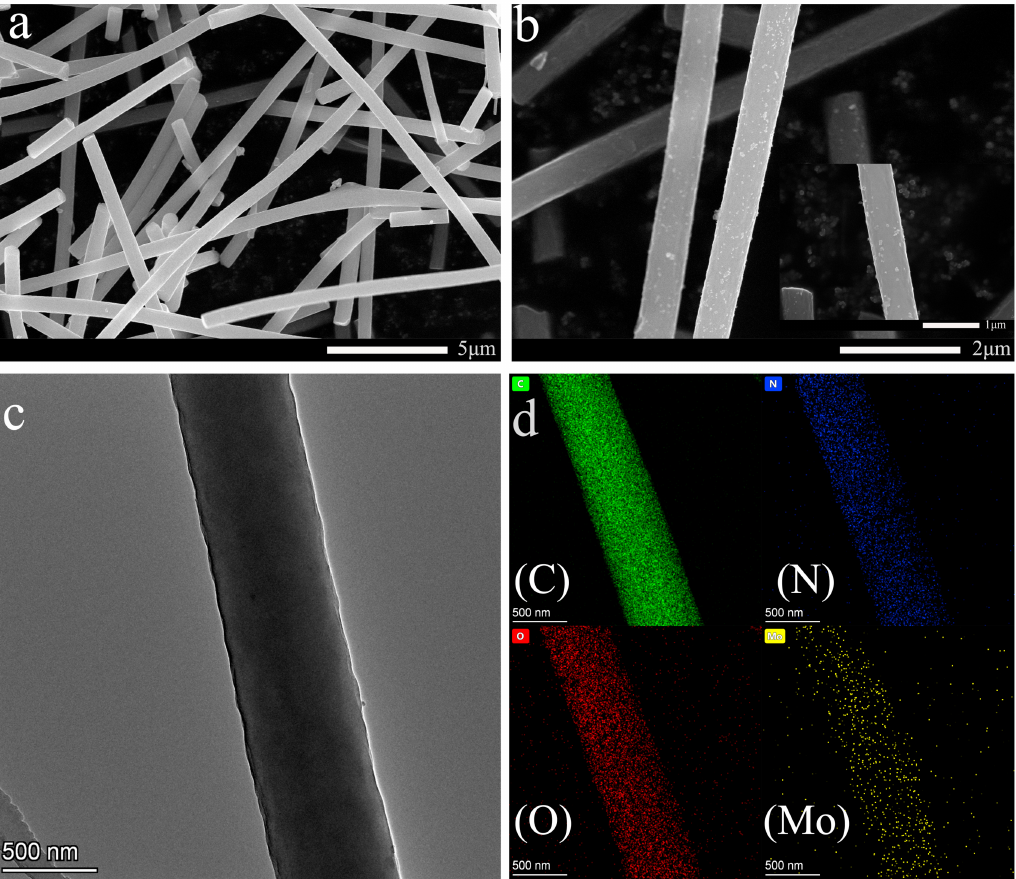
Figure 1. Characterization of Mo-CNFs and CNFs. SEM illustrations of ( a ) CNFs, ( b ) Mo-CNF II; ( c ) TEM image and ( d ) TEM element mappings of Mo-CNF